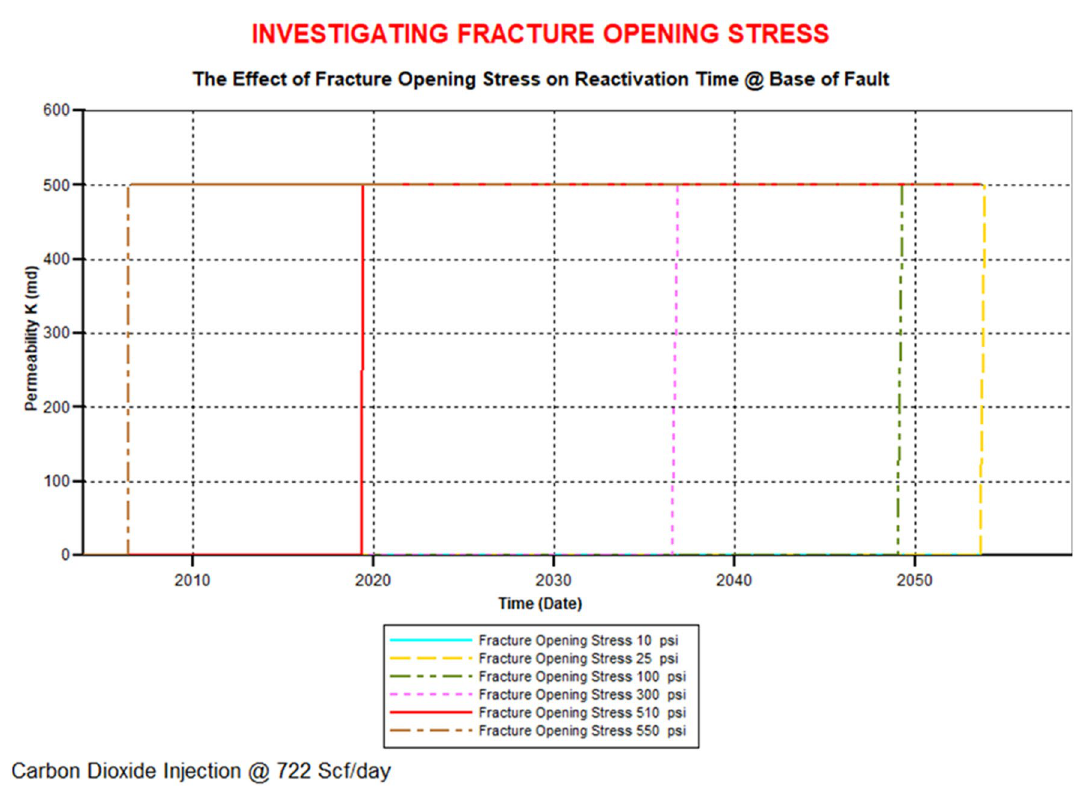
Fig. 14 Time taken for the onset of fault reactivation at the base of the fault for varying fracture opening